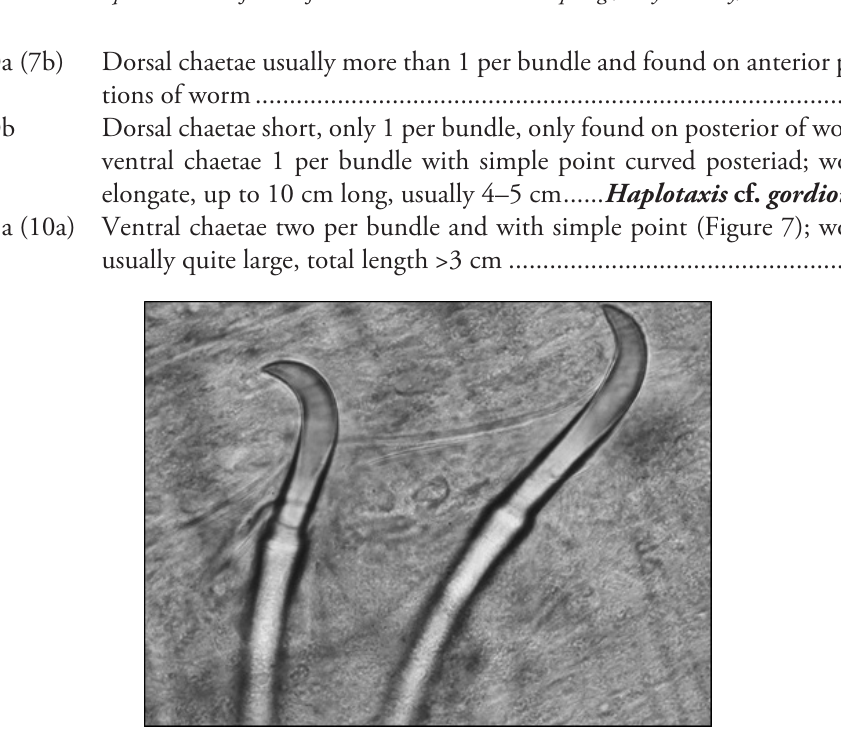
Figure 7. Paired chaetae typical of both dorsal and ventral bundles found on several lumbriculid taxa. 11b Ventral chaetae bifid, more than two per bundle with usually 3-9 per bun-